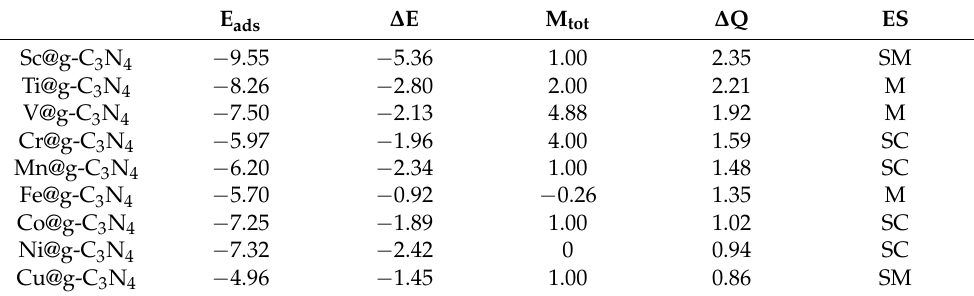
Table 1. Adsorption energies (E ads , eV), energy difference (ΔE, eV) between adsorption energy and cohesive energy, total magnetic moments (M tot , μ B ), the charge (ΔQ, e) transferred from the TM at- oms to g-C 3 N 4 monolayer, and the electronic structures (ES) (SM: semi-metallic, M: metallic and SC: semiconductor).